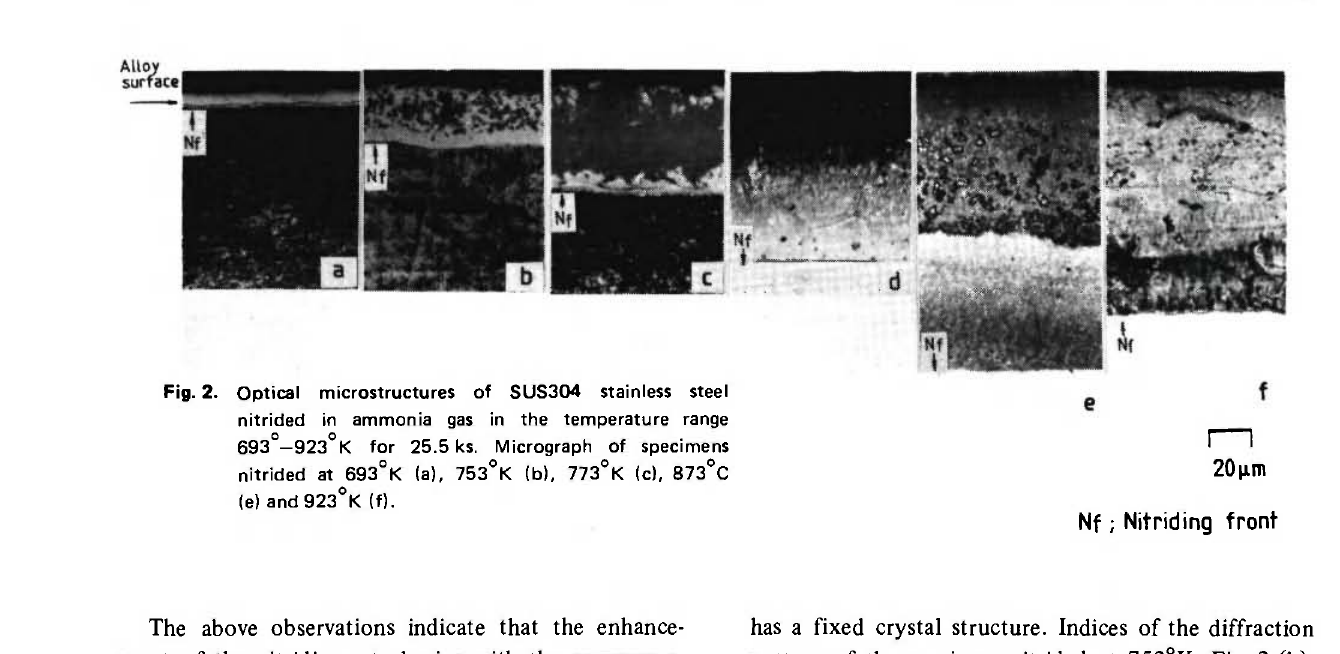
Fig. 2. Optical microstructures of SUS304 stainless steel nitrided in ammonia gas in the temperature range 693°-923°K for 25.5 ks. Micrograph of specimens nitrided at 693°K (a), 753°K (b), 773°K (c), 873°C (e) and 923°K